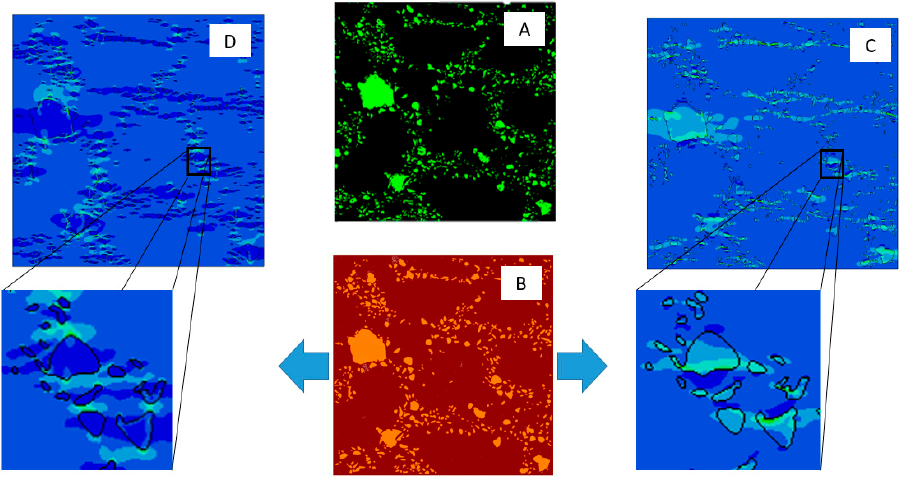
Figure 14. Local stress transfer across particles under tensile loading for fully bonded and nonbonded interaction: ( A ) original SEM image, ( B ) computational RAE, ( C ) fully bonded stress field in tensile direction, ( D ) nonbonded stress field in tensile direction.